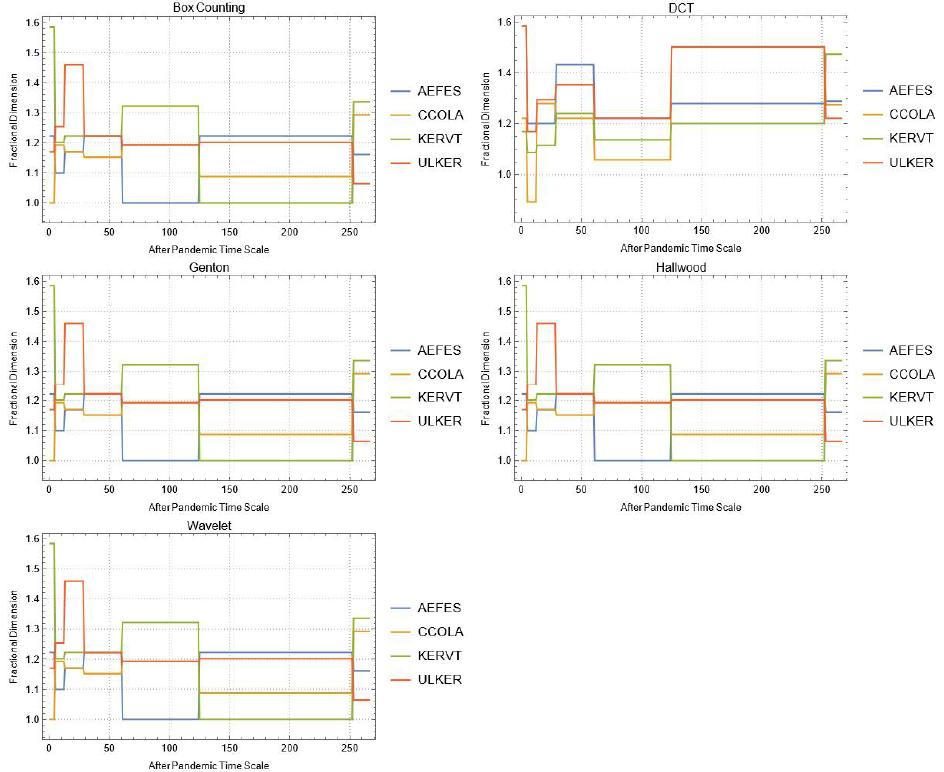
Figure A18. Daily changes of fractal dimensions after the pandemic (metal industry).